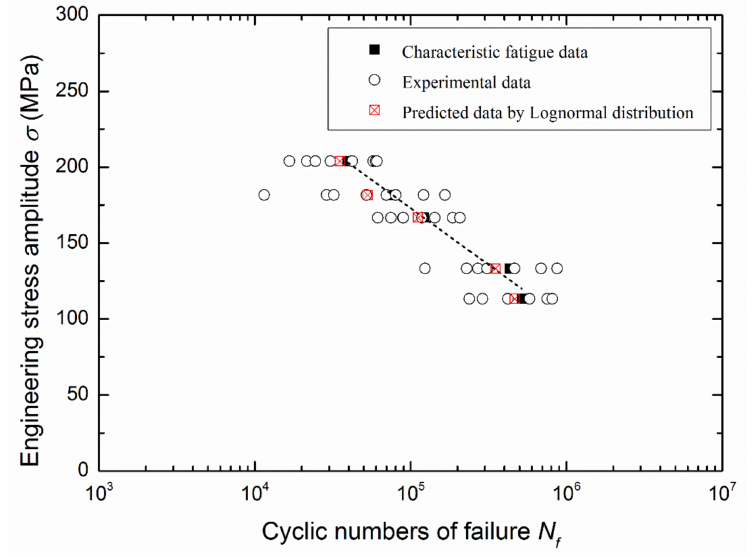
Figure 10. Experimental data and predicted data of fatigue lives for 7075-T7351 Al alloy under different stress amplitudes in